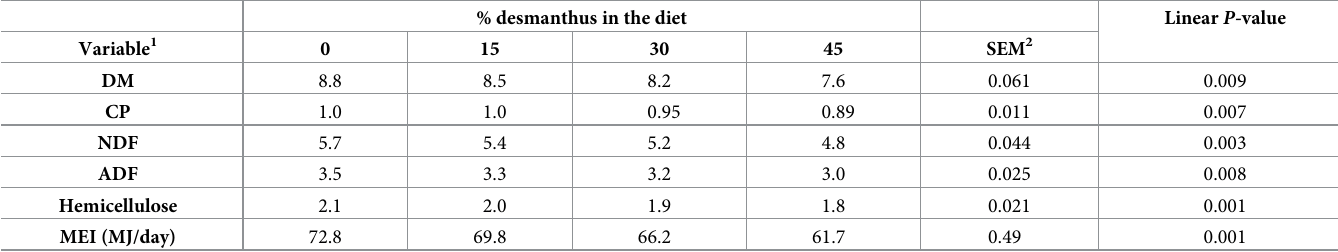
Table 4. Effect of desmanthus proportion on nutrient